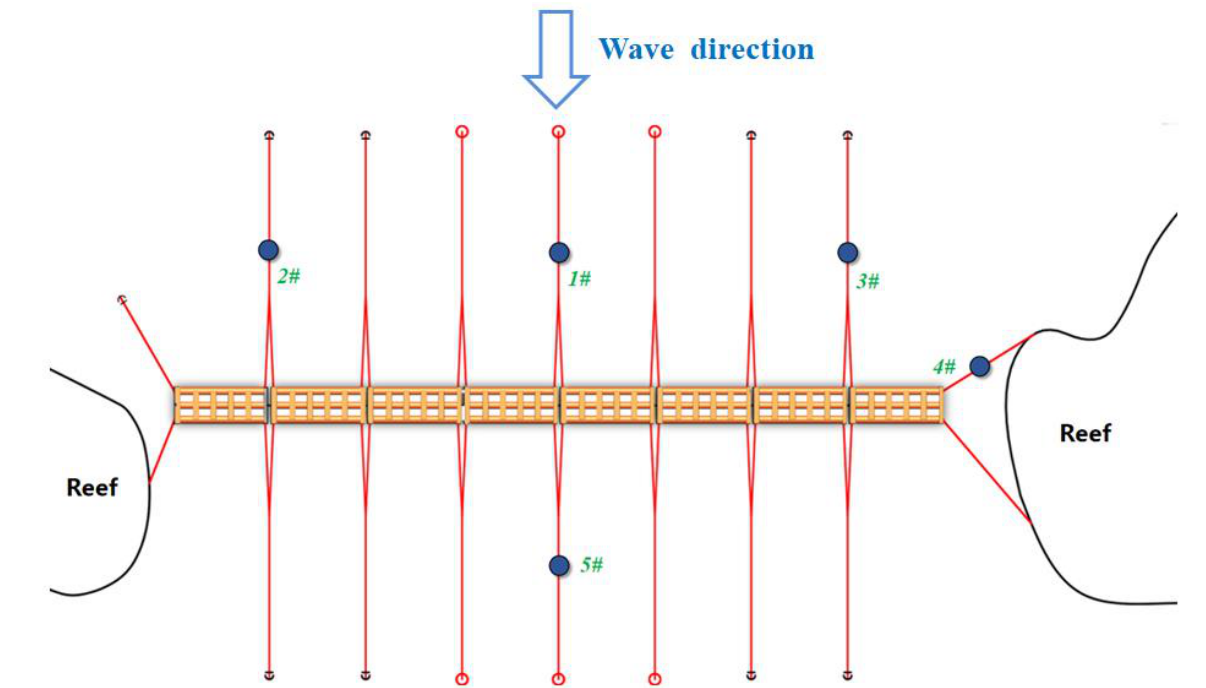
Figure 8. Schematic diagram of load cells measuring point layout.